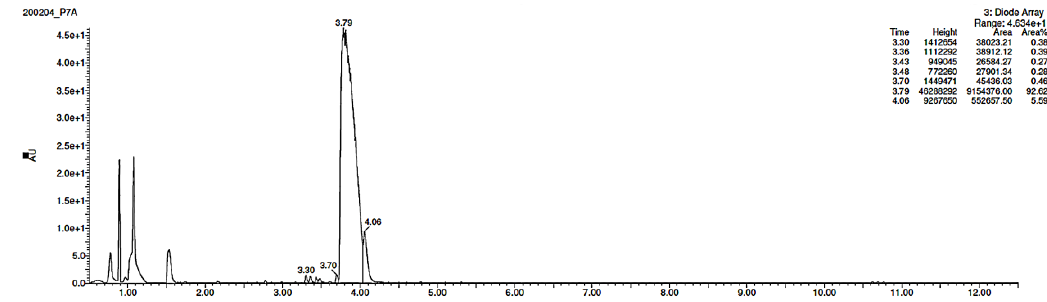
Figure 9. UPLC chromatogram of epinastine (EPI) and its degradation products in a solution of pH 3.0.